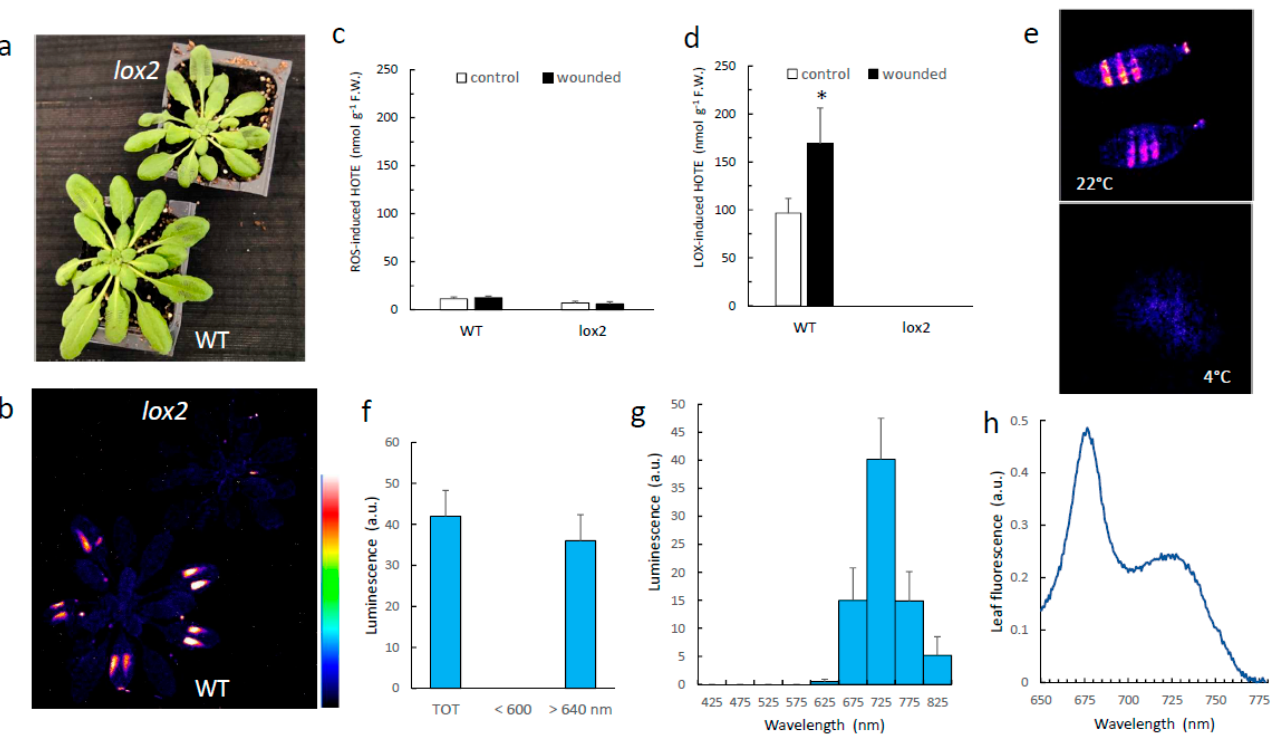
Figure 1. SCL emission induced by leaf wounding in WT Arabidopsis plants and in the lox2 mutant. ( a ) Picture of the plants after leaf wounding. ( b ) SCL images of the corresponding plants. The colour palette indicates the signal intensity from low (dark blue) to high (white) values. ( c , d ) ROS-mediated and LOX-mediated HOTE levels in control leaves and in wounded leaves. *, significantly different from WT at p < 0.01 (Student’s t -test). ( e ) Wounding-induced SCL in WT Arabidopsis leaves at 22 °C and at 4 °C. ( f ) Wounding-induced SCL intensity in two wavelength ranges, >640 nm and <600 nm. ( g ) Spectrum of wounding-induced luminescence in WT leaves. ( h ) Chlorophyll fluorescence emission of a WT Arabidopsis leaf at room temperature. TOT = total signal intensity.